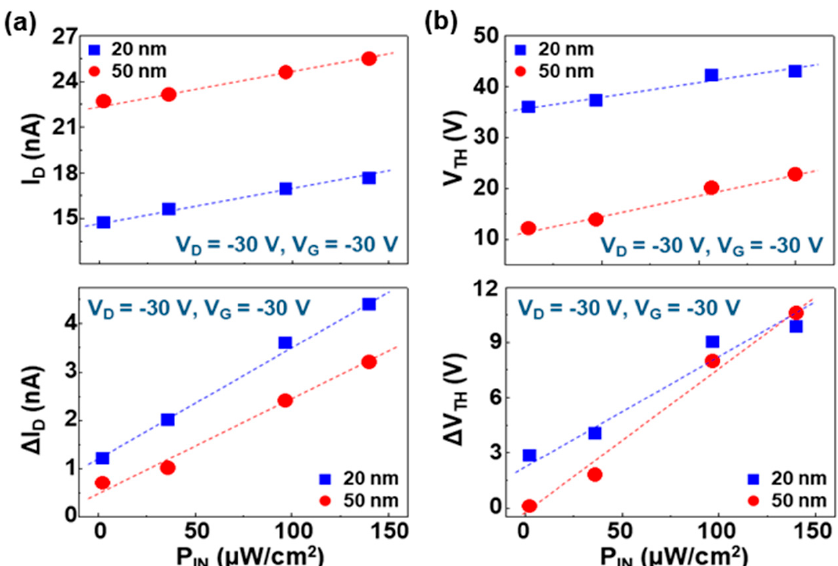
Figure 4. Variation of sensing parameters (taken from the transfer curves in Figure 3) as a function of the incident low-power NIR light intensity (P IN = ca. 2.3~140.2 µW/cm 2 ): ( a ) drain current (I D ) and net drain current ( ∆ I D ), ( b ) threshold voltage (V TH ) and threshold voltage shift ( ∆ V TH ). The slope